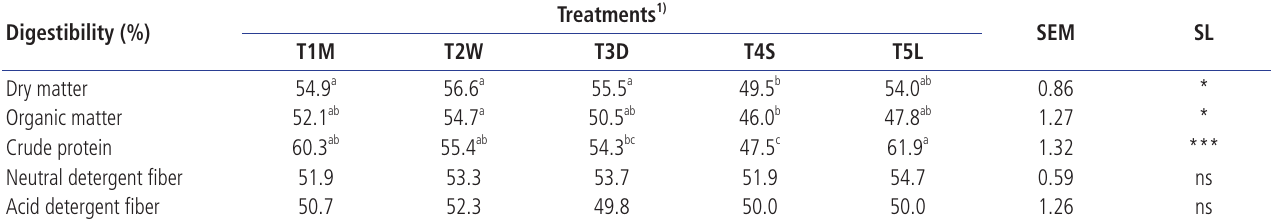
Table 3. Apparent nutrient digestibility of diets containing different varieties of faba bean straws (70%) and concentrate (30%) fed to Arsi-Bale sheep Digestibility